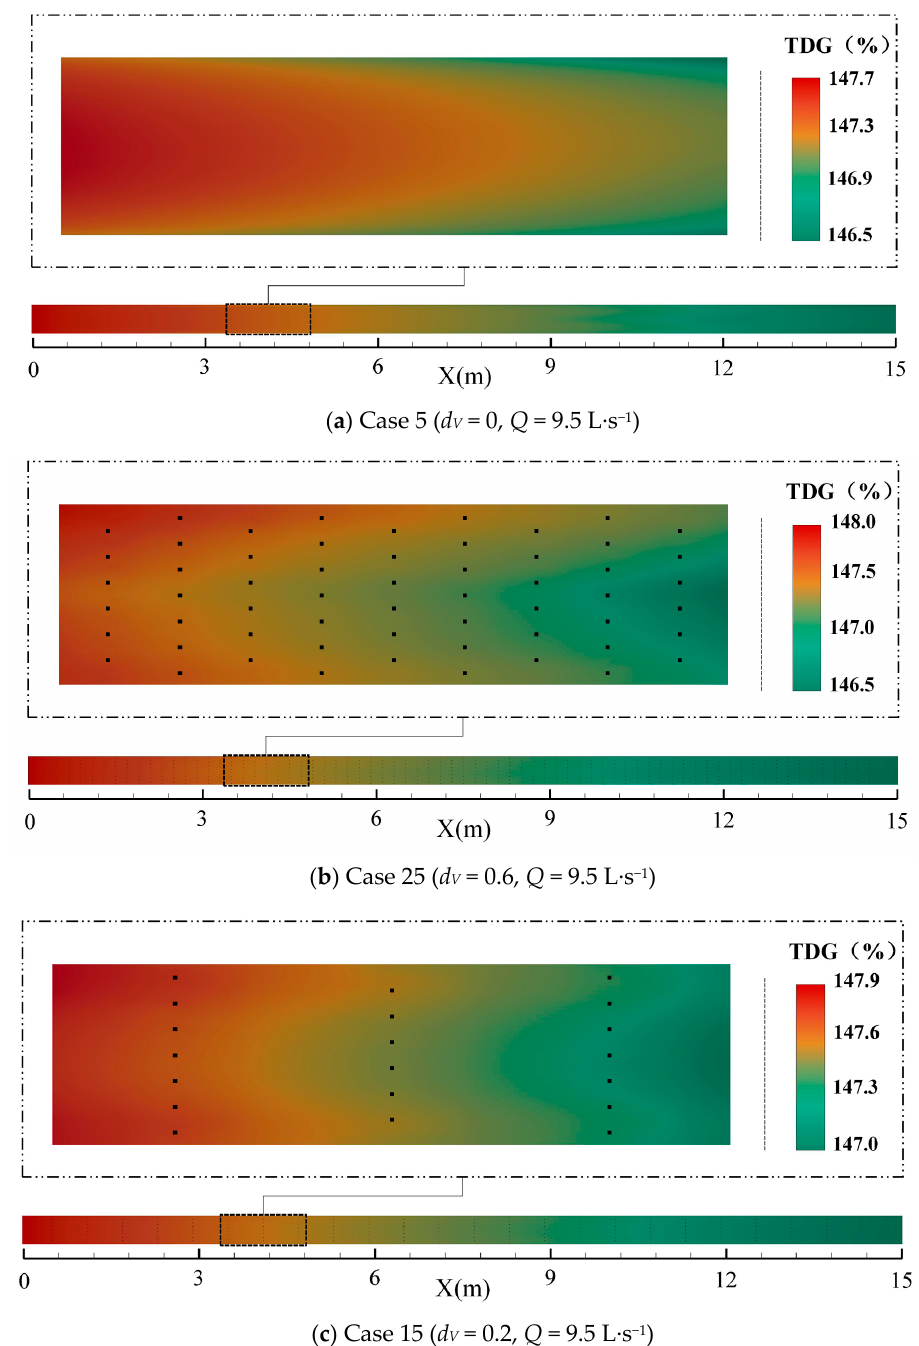
Figure 13. The scattergram of supersaturated TDG on a horizontal plane.